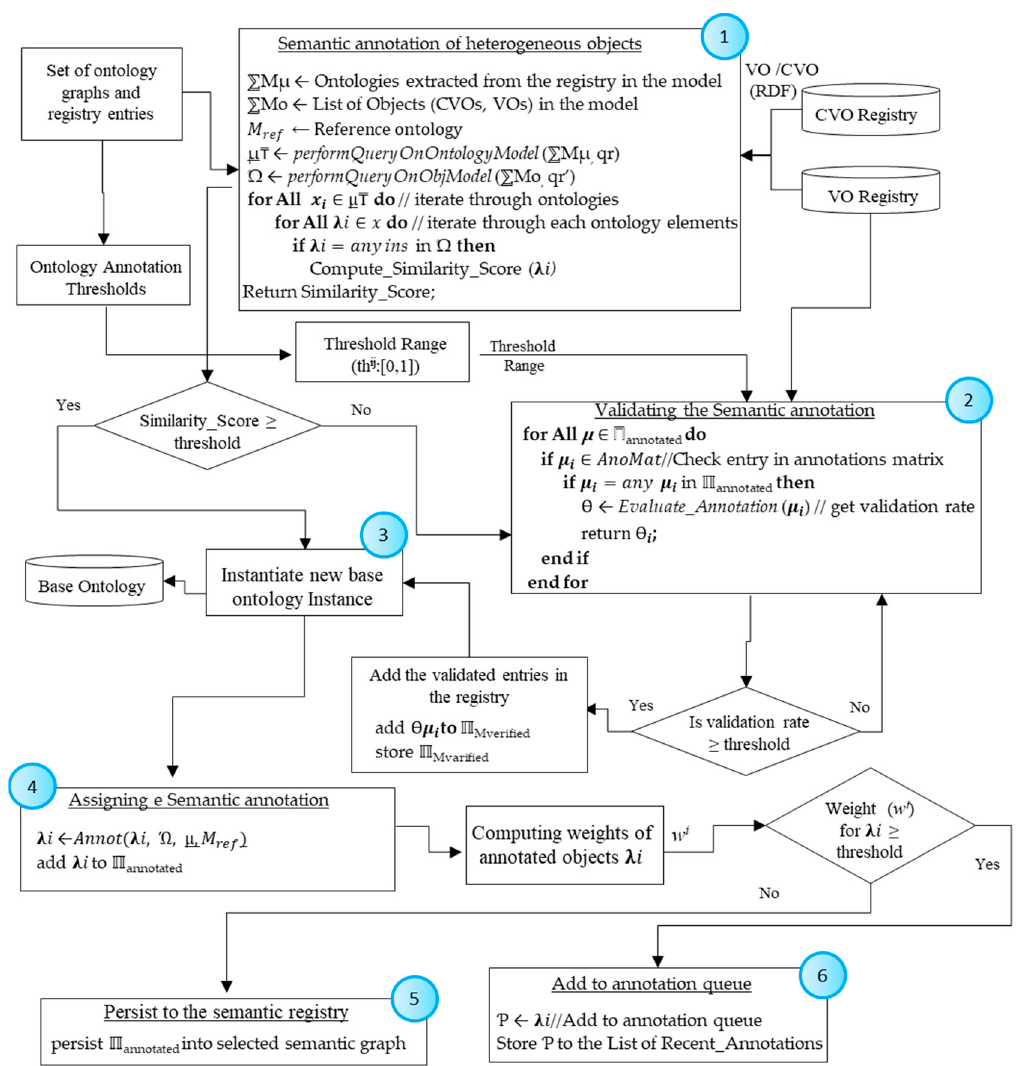
Figure 7. Flow Chart of the semantic annotation algorithm.